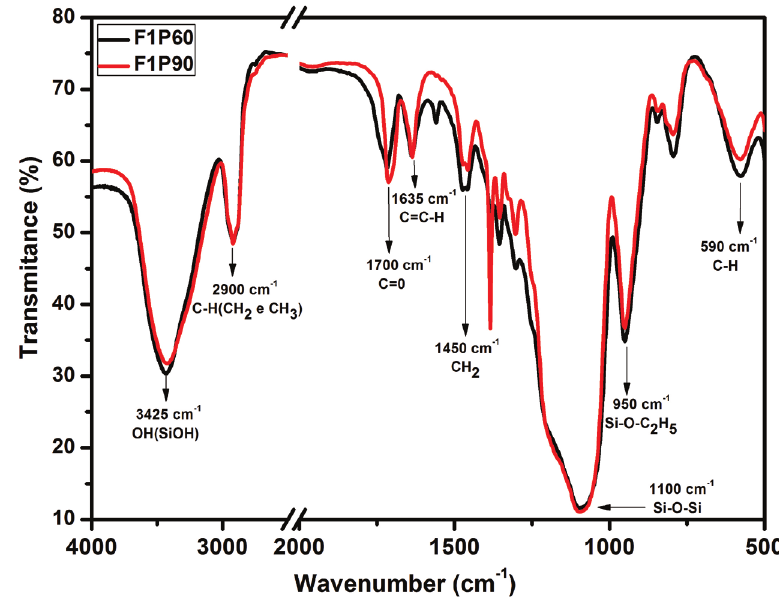
Figure 4. FTIR spectra of the hybrid films formulated with the different temperatures (F1P60 and